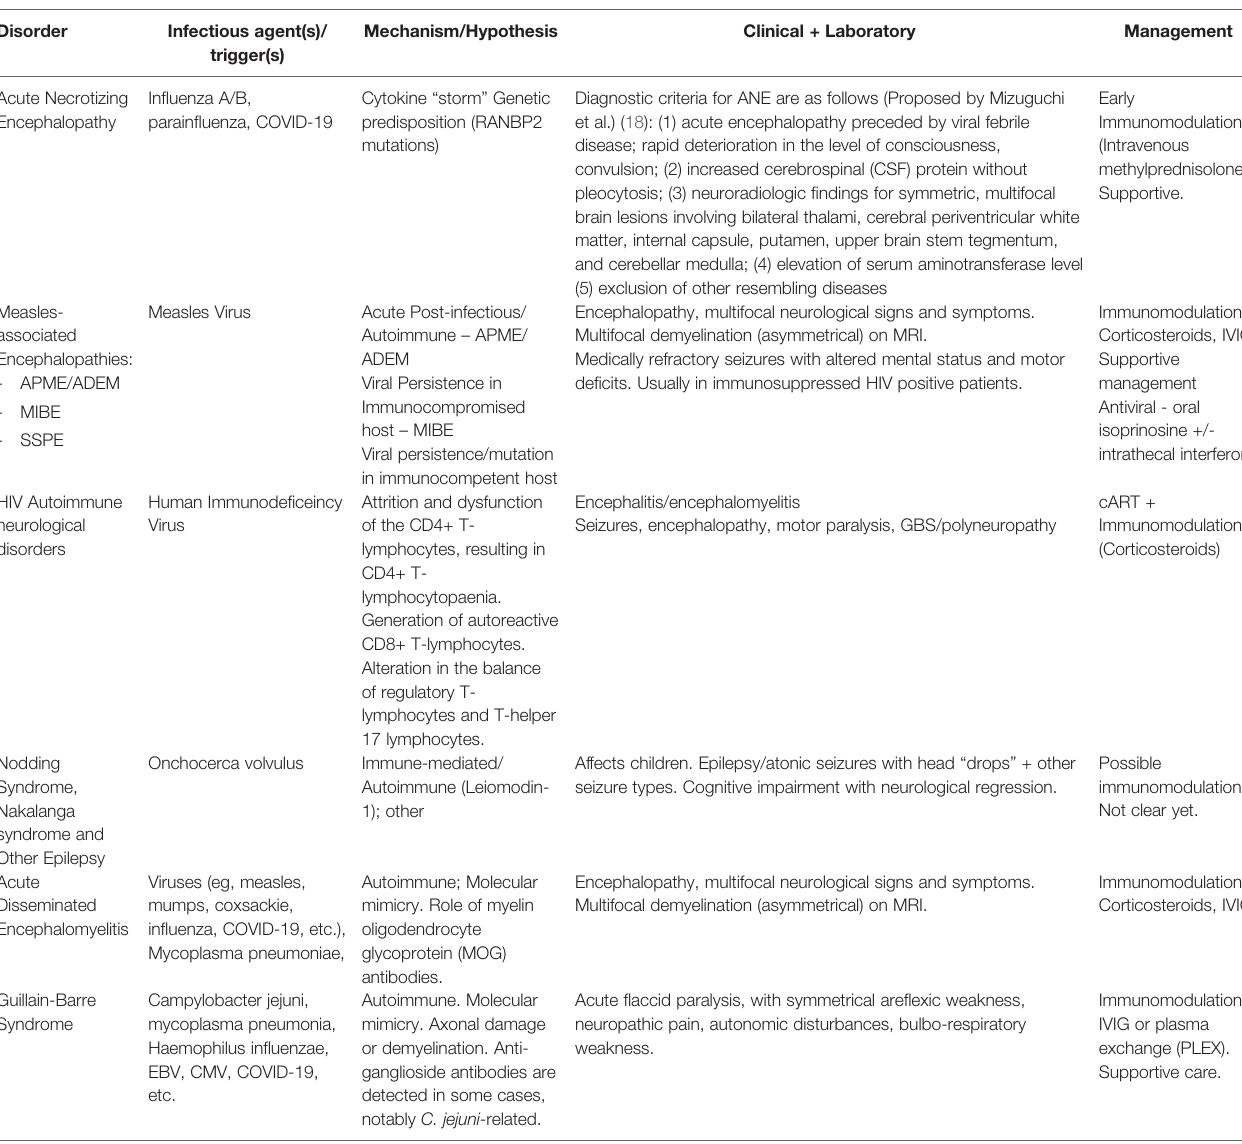
TABLE 1 | General overview of para- and post-infectious autoimmunity in the central and peripheral nervous systems (see text references). Disorder Infectious agent(s)/